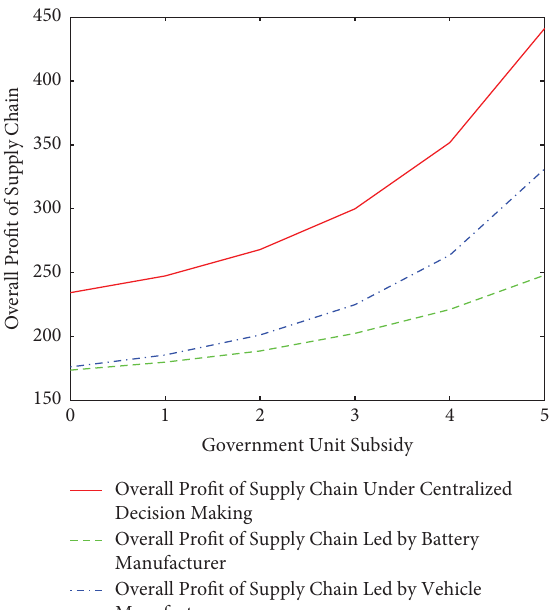
Figure 5: Te infuence of government subsidies on overall profts under diferent power structures.